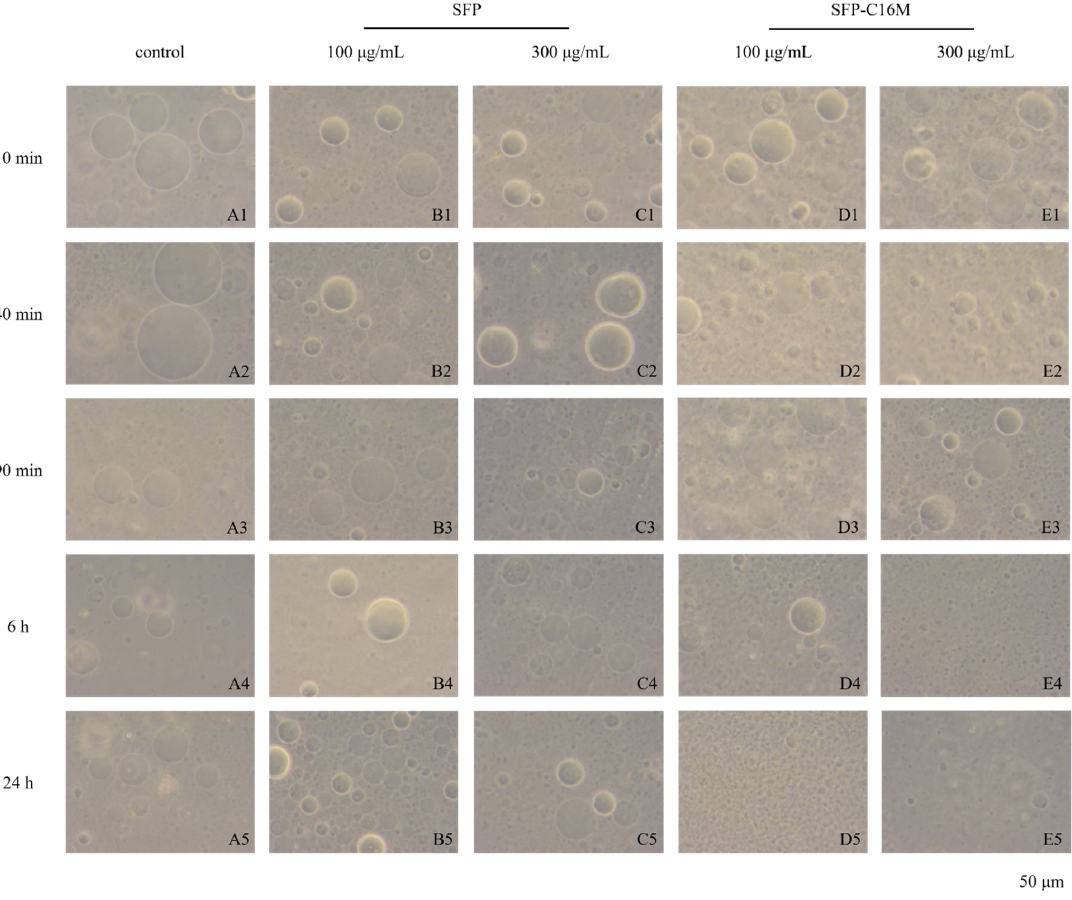
Figure 8. Morphology of GUVs – after 10 min, 40 min, 90 min, 6 h and 24 h of exposure to the SFP and SFP-C16M at different concentrations (100 µ g/mL and 300 µ g/mL) (200 × ). ( A ): control group; ( B ): 100 µ g/mL SFP group; ( C ): 300 µ g/mL SFP group; ( D ): 100 µ g/mL SFP-C16M group; ( E ): 300 µ g/mL SFP-C16M group; scale bar = 50 µ